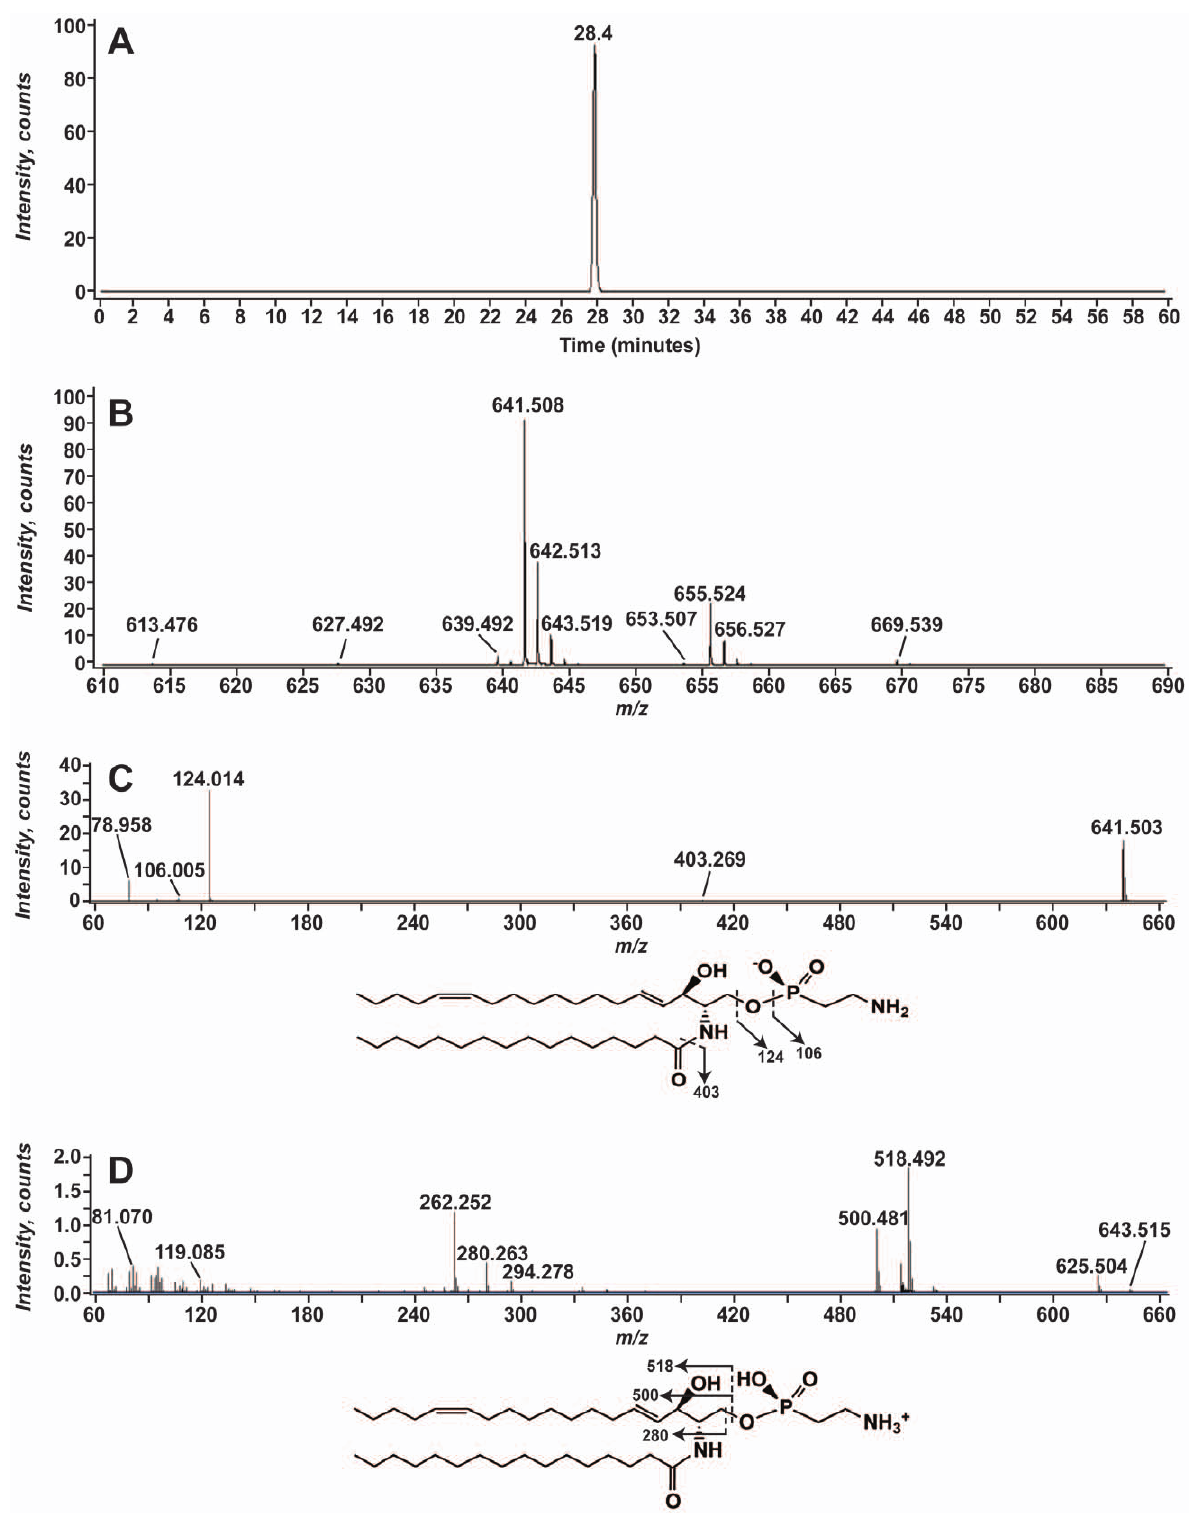
Figure 7. Mass spectrometry of the A.pallida phosphonosphingolipid at m/z 641.5. Panel A shows the EIC for 641.5. Panel B shows the negative-ion mass spectrum from m/z 610 to 690 for the lipids eluting between 27.3 and 28.1 minutes. The MS/MS spectra obtained in the negative- ion mode (Panel C) and the positive-ion mode (Panel D) are shown. The structures below each MS/MS spectra indicate predicted structure as well as selected product ions.